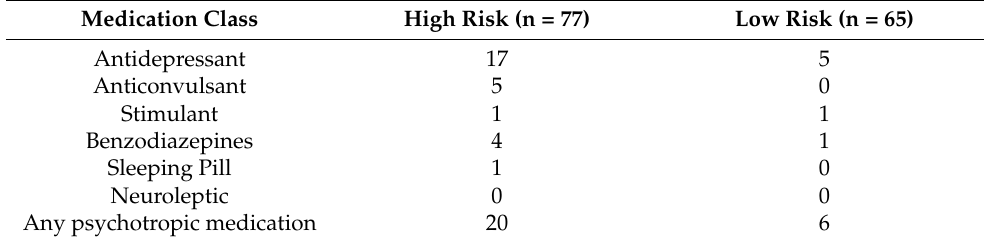
Table 4. Psychotropic Medication Use at the Time of MRI